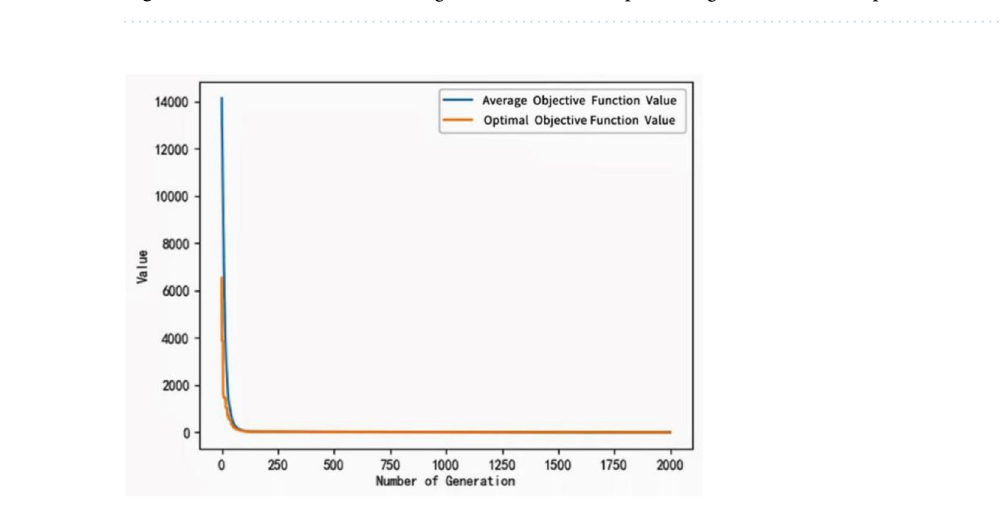
Figure 9. Test the function convergence curve of the improved algorithm with the Sphere test function.